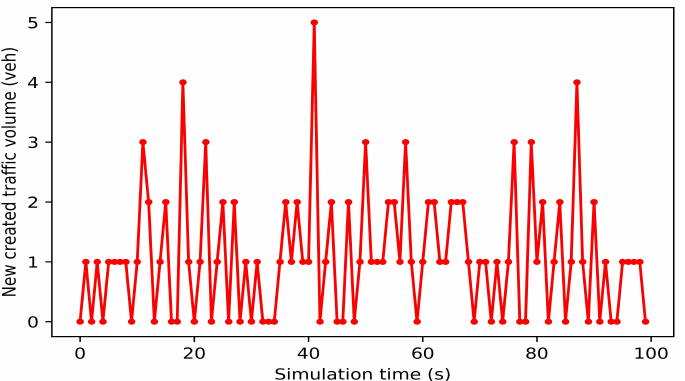
Figure 7. New traffic volume generated based on Poisson Distribution under 500 (veh/h/l) in the first 100